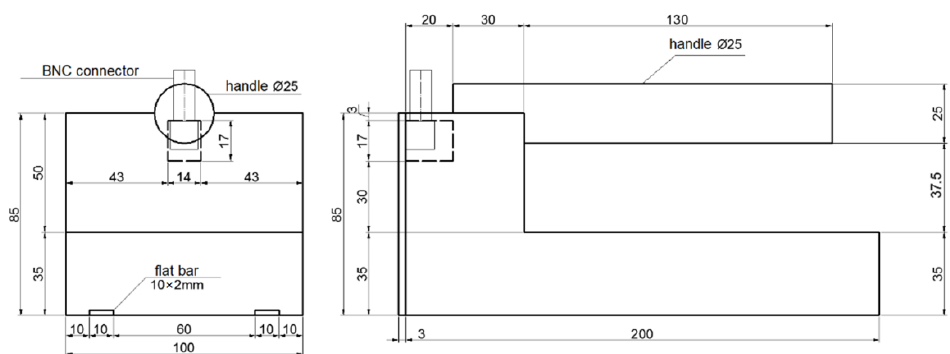
Figure 2. Sensor B Figure 2. Sensor B design. Figure 2. Sensor B design. Figure 2. Sensor B design.